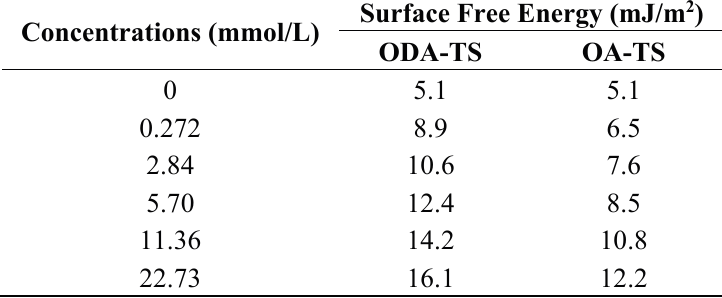
Table 2. Surface free energy values obtained for the steel samples exposed to different concentrations of OA-TS and ODA-TS in 1 M HCl